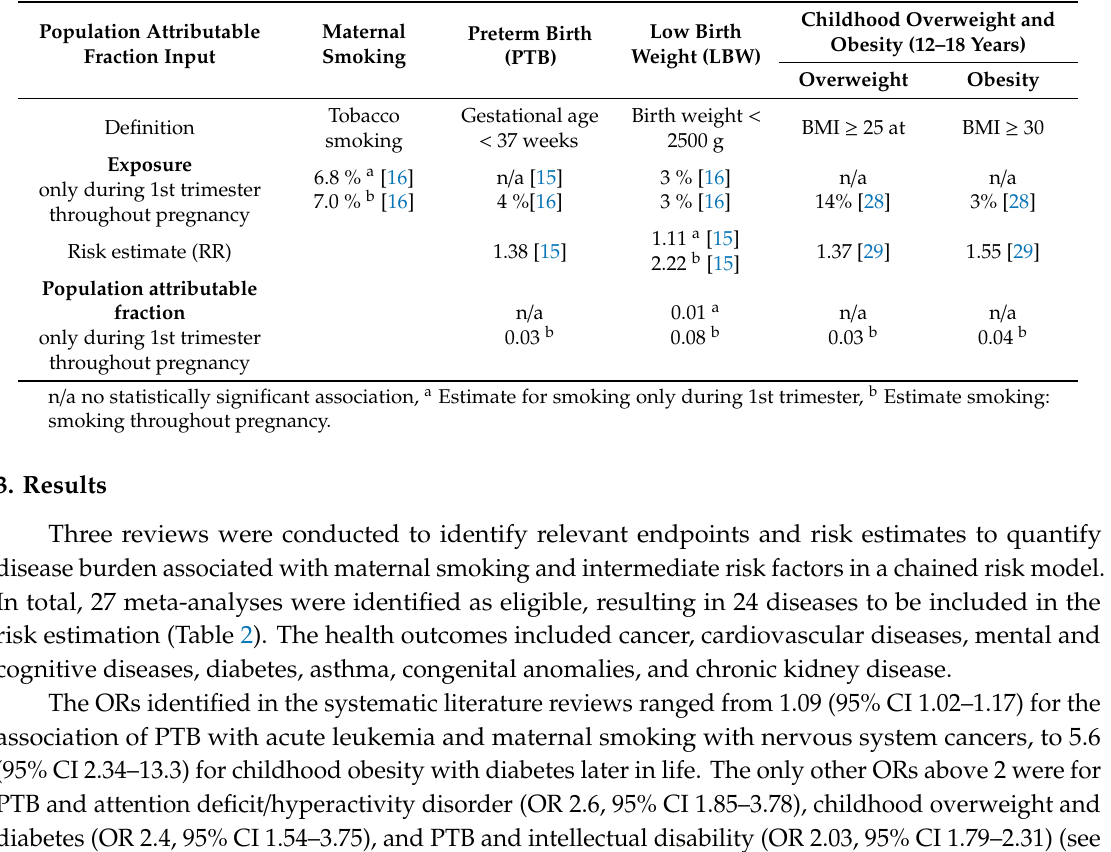
Table 1. Risk factor definition and population attributable fraction (PAF) estimation for the association between maternal smoking and the intermediate risk factors in this